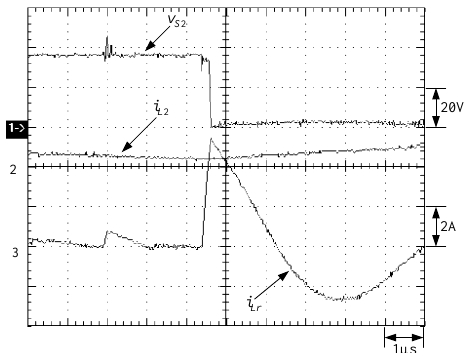
Figure 28. Waveforms pertaining to S 1 , L 1 and L r at the rated load: (1) v S 1 ; (2) i L 1 ; and (3) i Lr .